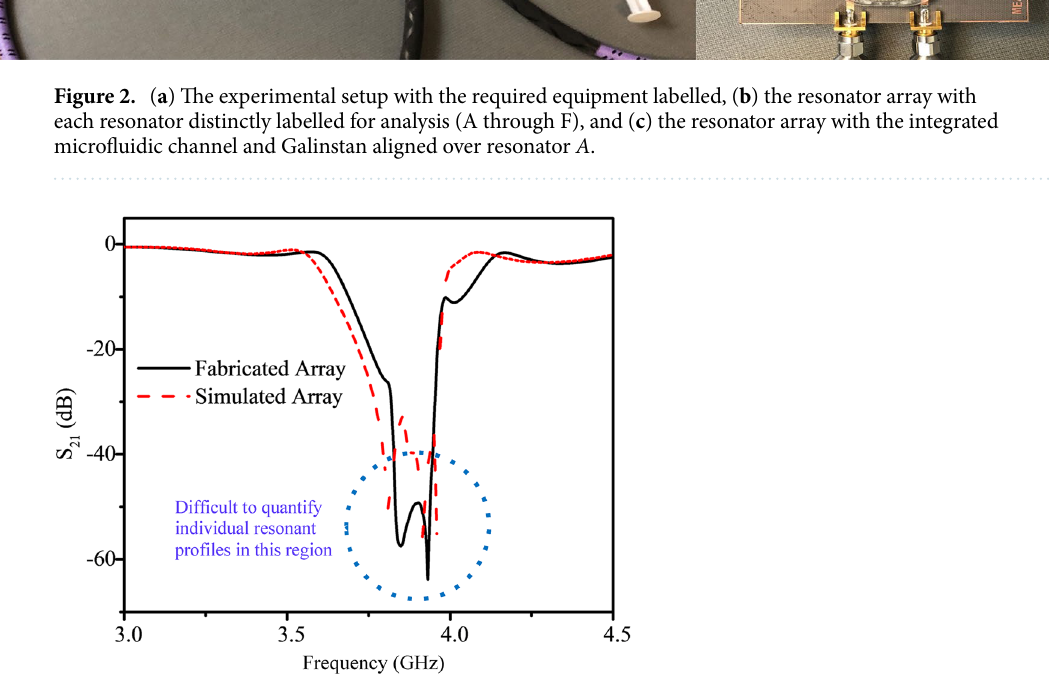
Figure 3. Simulated and fabricated S 21 response of the resonator array highlighted the difficulty in isolating and analyzing individual resonant profiles because of multiple resonant responses overlapping at roughly the same frequency. Simulated results were generated from design using HFSS 19.0 (https:// www. ansys.